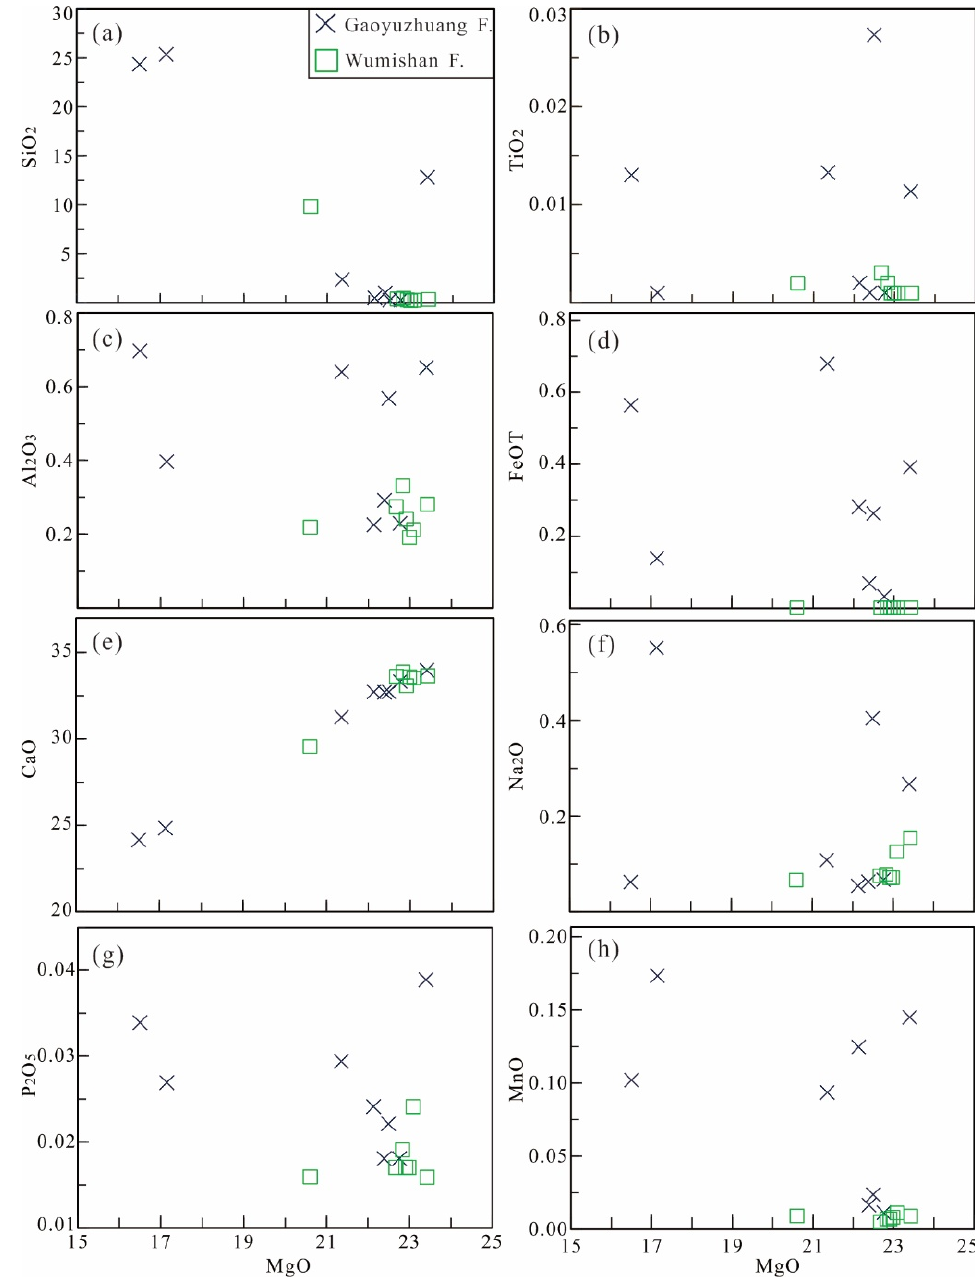
Figure 5. Plots of ( a ) MgO versus SiO 2 , ( b ) MgO versus TiO 2 , ( c ) MgO versus Al 2 O 3 , ( d ) MgO versus FeOT, ( e ) MgO versus CaO, ( f ) MgO versus Na 2 O, ( g ) MgO versus P 2 O 5 , and ( h ) MgO versus MnO for the carbonate rocks from the Gaoyuzhuang and Wumishan Formations.